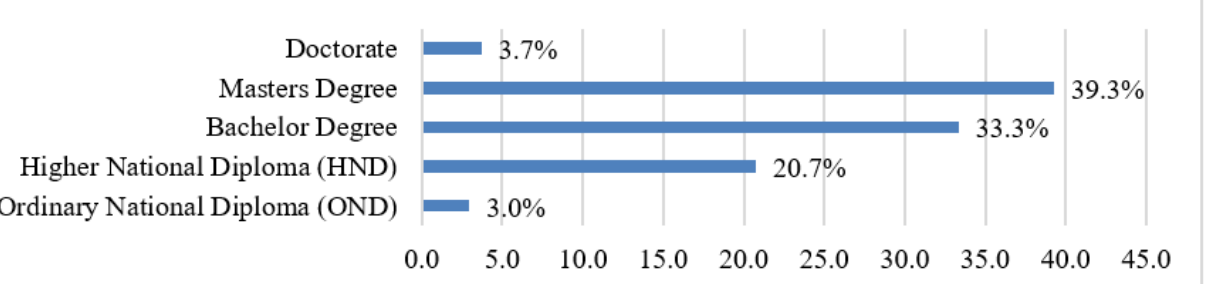
Figure 4. Respondents’ educational qualifications. Table 1. Methods of resolving conflict among construction professionals.